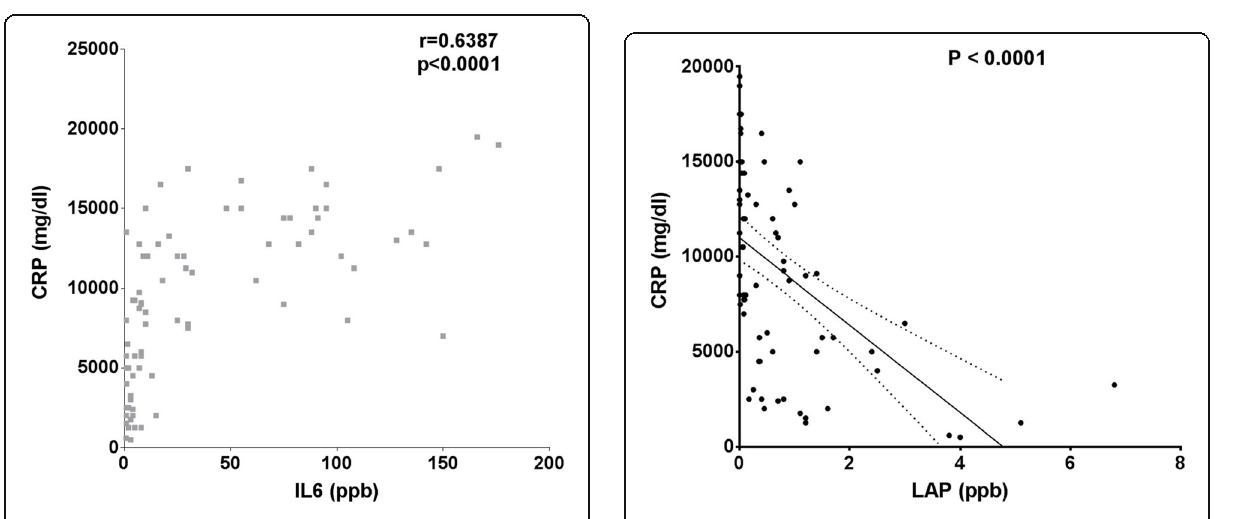
Fig. 3 Correlation between IL-6 and CRP Fig. 4 Linear regression between LAP and